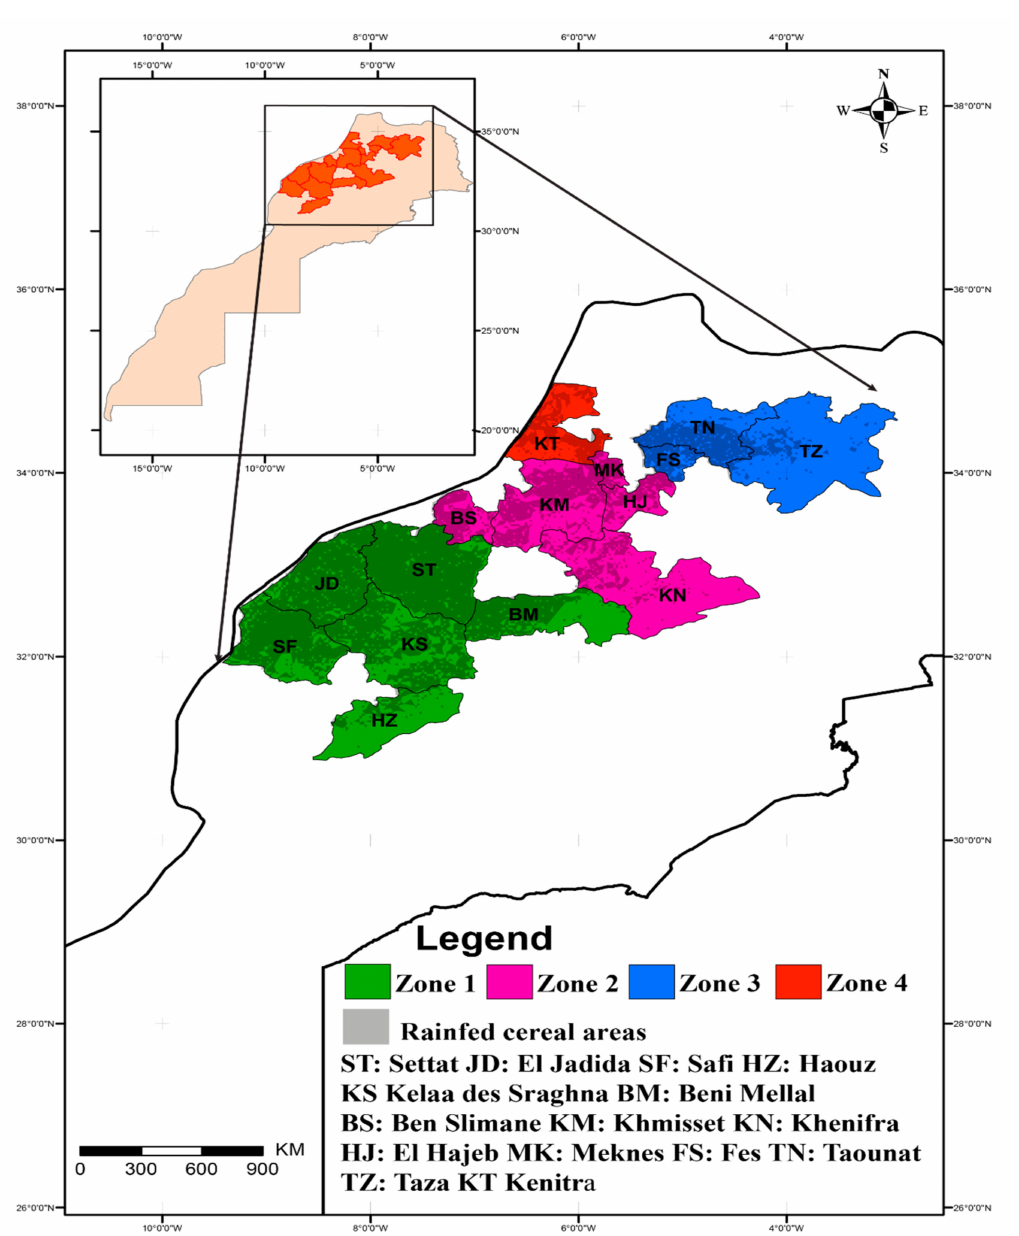
Figure 1. Maps of the 15 most productive provinces considered in the study in terms of cereal yields and results of the four classifications (see text). The agricultural areas identified as rainfed cereal are